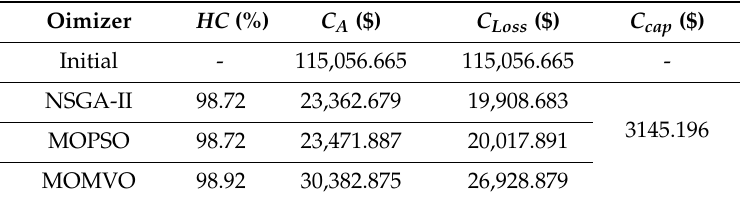
Table 2. Deterministic results for 59-node distribution system.